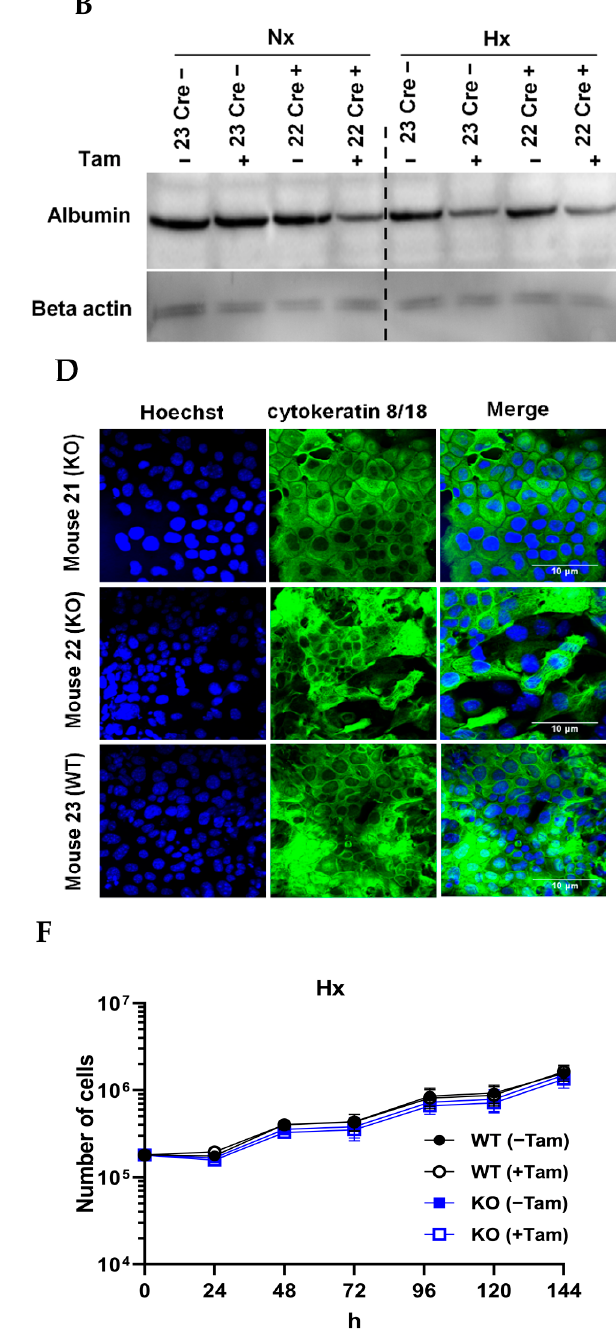
Figure 2. Analysis of differentiation of mHDC. Tam+ indicated tamoxifen treatment. NX designated the incubation in normoxia, HX in hypoxia (1% oxygen). ( A ) Phase contrast microscopy of nearly confluent cultures of mHDC monolayers. ( B ) Albumin Western blot of mHDC protein lysates. (Thirty micrograms per lane was loaded onto the gel. Hypoxic incubation was for 24 h). Cre-mHDC were isolated from Cre-negative mice, Cre+ were from Cre positive animals. Beta-actin served as a control for equal loading and protein transfer. ( C ) Cell culture media of mHDC were analyzed for secretion of murine acetylcholine esterase by ELISA. ( D ) Expression of CK8/CK18 was analyzed by immunofluorescence staining. Cell nuclei were counterstained with Hoechst33342. ( E , F ) Cell counting of mHDC under normoxic or hypoxic conditions. The mHDC were transferred to normoxia (NX) or hypoxia (HX) 24 h after seeding and counted for up to 5 days after transfer.